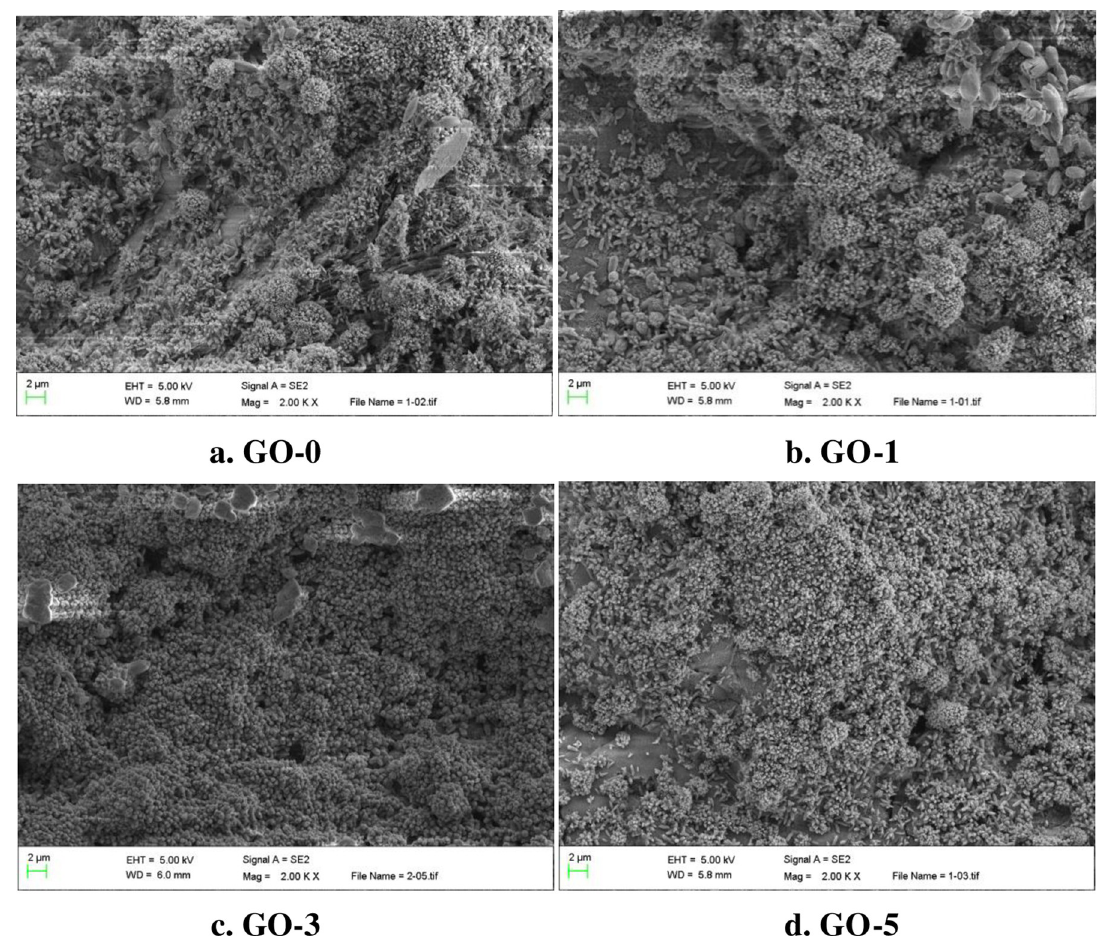
Fig 13. Microstructure of specimens after 28 days